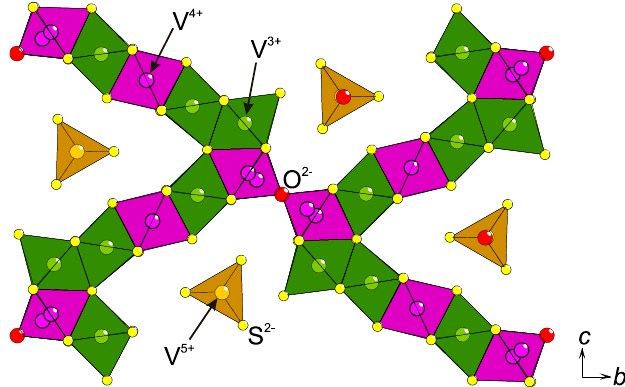
ordering is emphasized with different colors: V 3+ (green), V 4+ (purple), and V 5+ (yellow) [18]. At the V  O  V junction, both half-occupied split-positions of V are